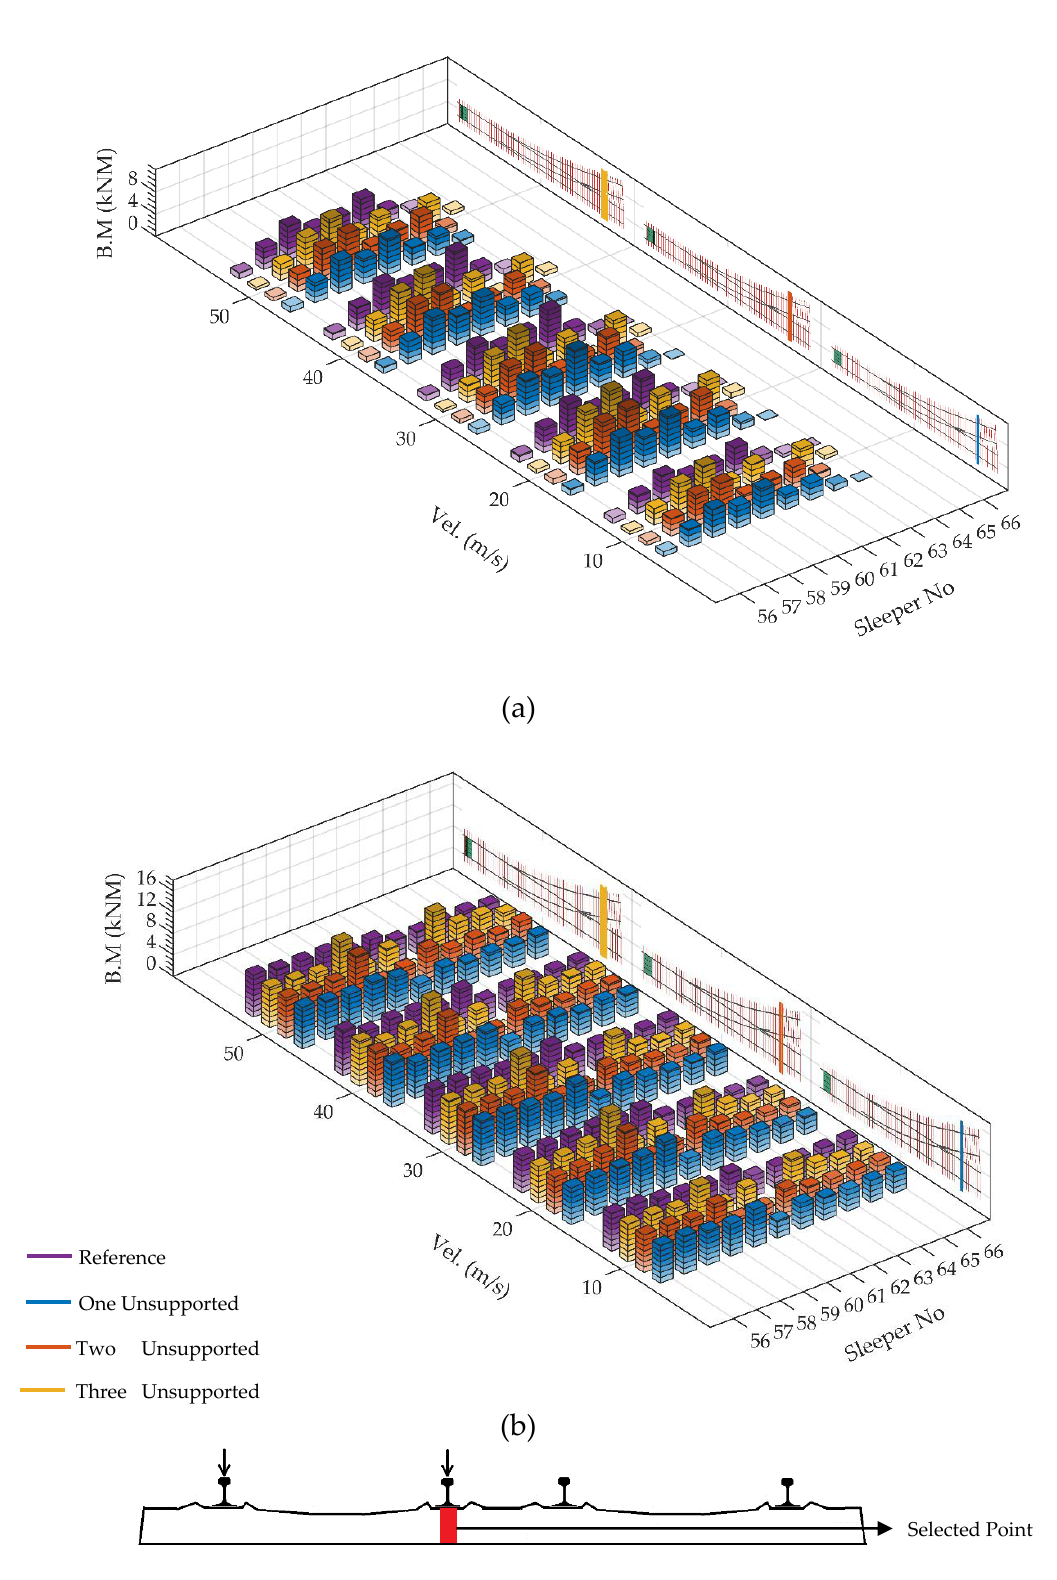
Figure 26. The distribution of positive bending moments over the bearers when the longest bearer is unsupported: ( a ) at particular time when the front wheel is on the bearer with number 61; ( b ) when maximum occurs at each bearer.